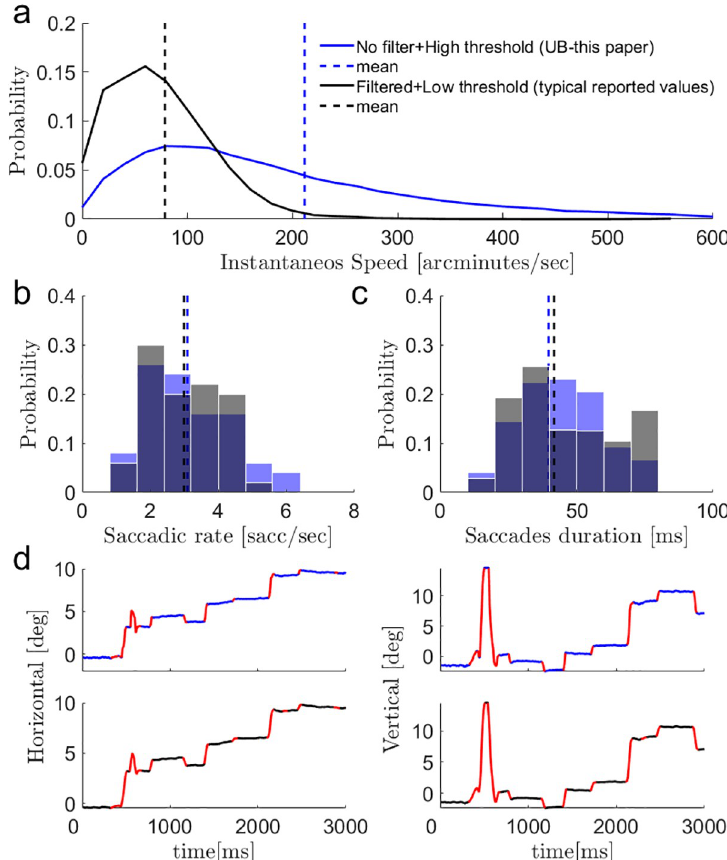
Fig 2. Bounds of drifts kinematics. (a) Distribution of the instantaneous drift speeds of all measured fixational pauses of the experiment. Two methods were used: 1.the upper bound (UB) was assessed by derivation of the raw eye position data, and thus using a higher saccadic detection threshold of 16 deg/s for minimal peak velocity and 0.3 deg for minimal amplitude (blue, UB–these are the values reported in this paper). 2. A commonly used published method was assessed by filtering (a third order Savitzky-Golay filter with window size of 3 samples [45]) and thresholding (lower saccadic detection thresholds: 3 deg/s for minimal peak velocity and 0.05 deg for minimal amplitude [45]) our data (black). (b) Distributions of saccadic rates calculated on all experimental data using our UB method (blue) and the typical reported one (black). No significant difference was found (p > 0.1, two tailed t-test) (c) Distributions of saccades durations calculated on all experimental data using our UB method (blue) and the typical reported one (black). No significant difference was found (p > 0.1, two tailed t-test). (d) A single trial example of saccades detection (red) on the horizontal and vertical recorded data, using our UB methods (upper panel, blue) and the typical reported one (lower panel, black). One mismatch can be seen on 2230ms.